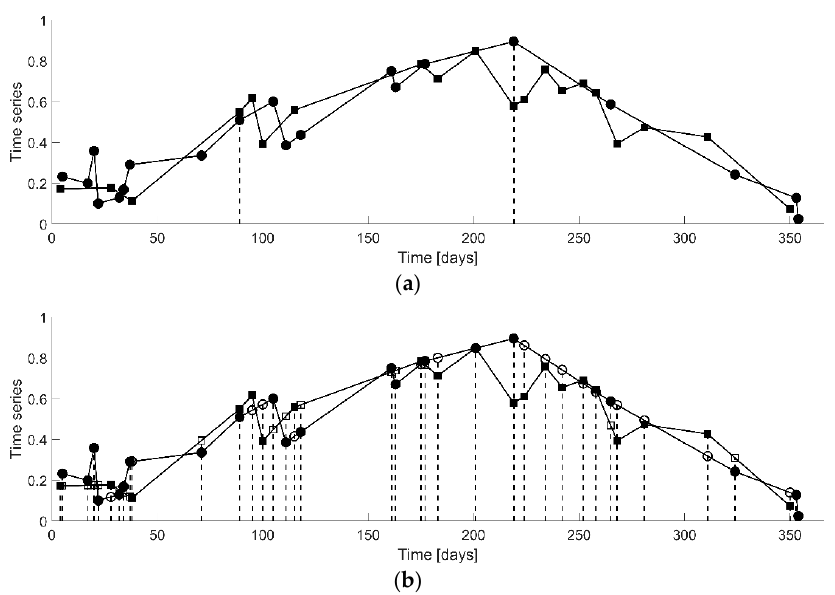
Figure 2. ( a ) Typical example of two time series observed by two different satellite sensors on the same area. The vertical dashed lines represent the two simultaneous observations. ( b ) The same curves after interpolation on the union of the dates (hollow circles and squares). The number of pairs increased to 38.